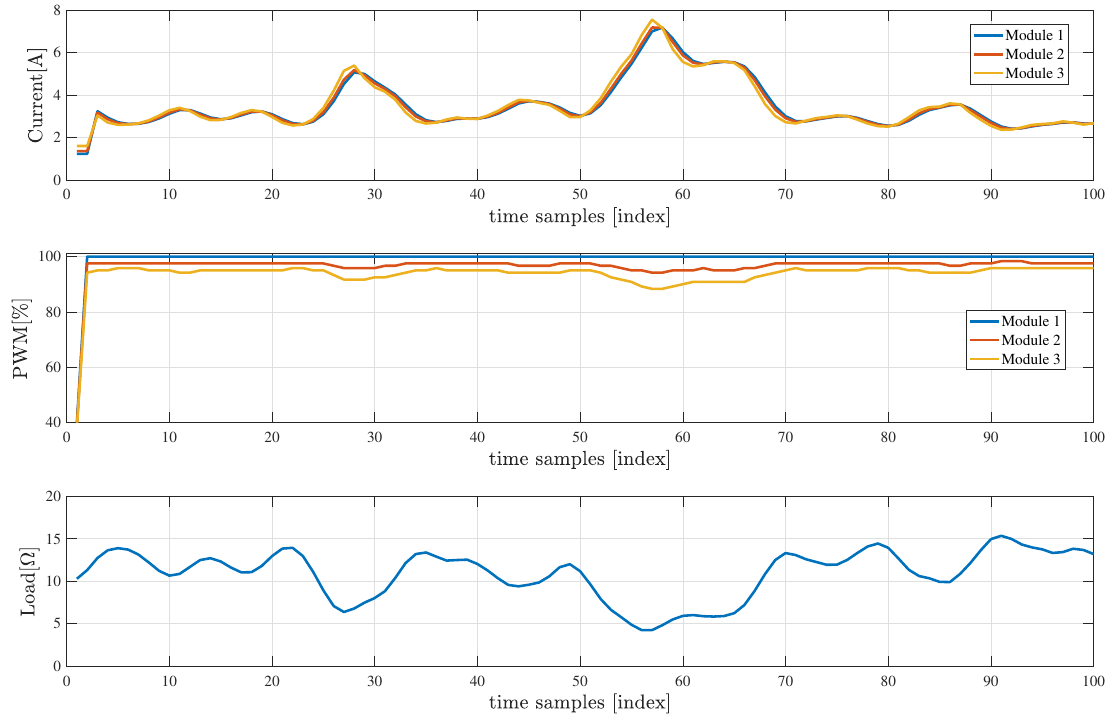
Figure 4. Currents in battery modules ( top ) and PWM modulation of battery voltage ( middle ) for recursive SOC balanced module scheduling of three parallel placed battery modules with accurate estimated internal impedance, subjected to a time-varying external load ( bottom